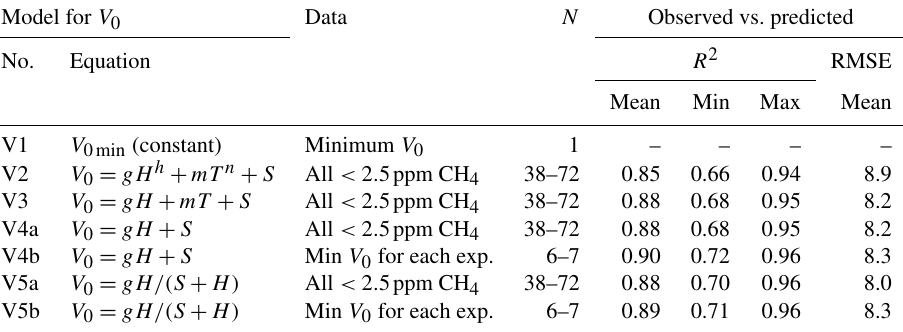
Table 1. Model results for Step 1 of sensor calibration – i.e., the correction of reference output voltage ( V 0 in millivolts) in background air to humidity and temperature. V 0min , H , and T , represent the minimum V 0 for each sensor (mV), absolute humidity (ppm), and temperature ( ◦ C) during measurements in open air. The model parameters g , h , S , m , and n are constants for each sensor derived by curve fitting. The model R 2 is the adjusted coefficient of determination (mean, minimum, and maximum for the 20 sensors tested), and RMSE is then root- mean-square error. Equivalent models using relative humidity (RH; %) instead of H , returned lower R 2 , and higher RMSE and are not shown. These Step 1 models were combined with the Step 2 models as noted in Table 2. N denotes number of values used. See text for details. Model for V 0 Data N Observed vs. predicted No.